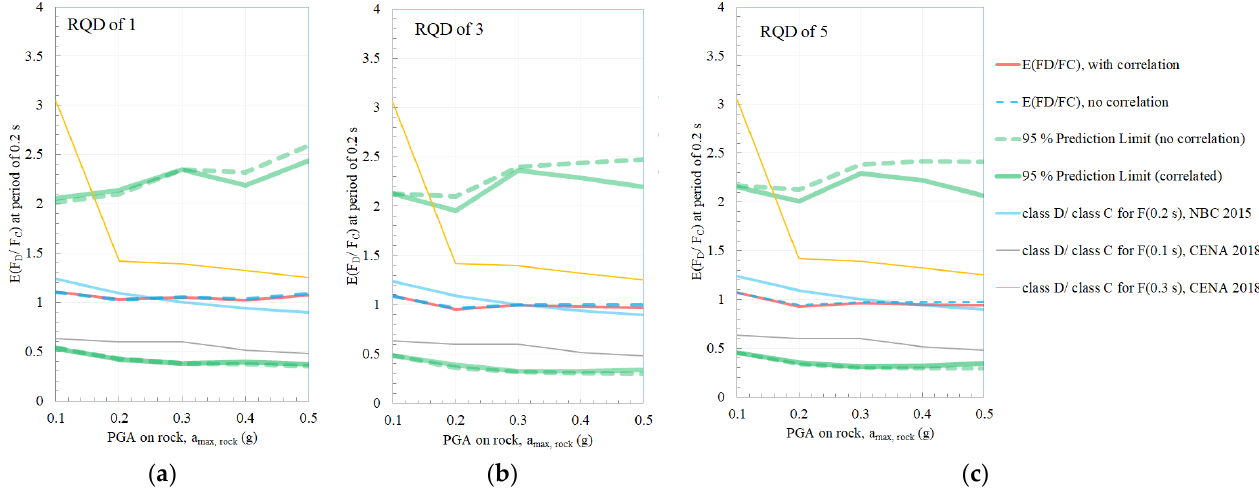
Figure 19. Comparison between (F D /F C ) at T = 0.2 s and the NBCC (2015) and the site factors in NBCC (2015) and the CENA site factors published by Hashash et al. [11] for RQD of 1 ( a ), 3 ( b ) and 5 ( c ).